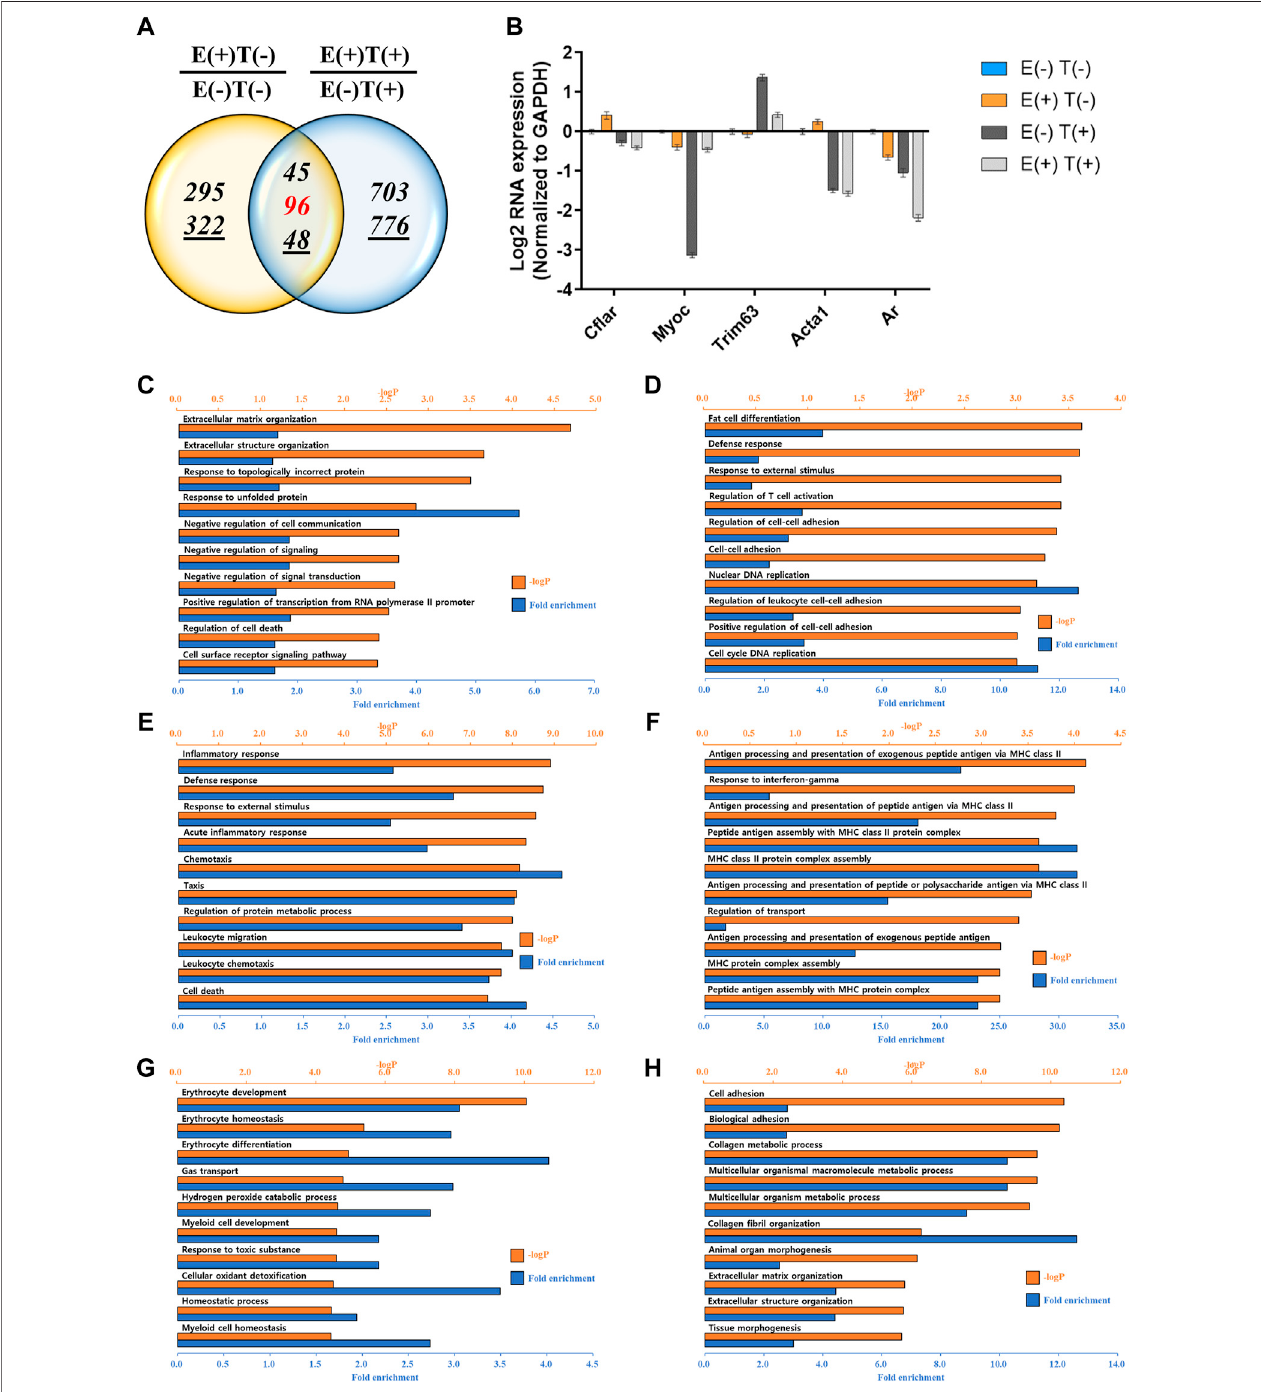
FIGURE 5 | mRNA-seq analysis of the heart. (A) Venn diagram of the number of DEGs for the effect of exercise for normal [E(+)T( − )/E( − )T( − )] and tumor-bearing [E(+)T(+)/E( − )T(+)] mice. The italicized number indicates the number of upregulated genes while the italicized and underlined number indicates the number of downregulated genes. Thosewith opposite effects between thetwogroups (contra-regulated) are shown inred. The DEGswerede fi ned asgeneswith afoldchangeof two and a normalized read count of four. (B) Bar graph of log2 fold change of selected genes in the contra-regulated group using RT-qPCR of the littermates. The foldchangewascalculatedbynormalizingthedatatothatof GAPDH andthentothelevelinthenormalcontrolgroup.Aconsistentchangecompared tothemRNA-seq analysiswasobserved. (C,D) GOanalysisoftheupregulated (C) ordownregulatedDEGs (D) comparingE(+)T( − )andE( − )T( − )mice.Exercisetriggeredtheexpressionof genes related to protein folding and matrix reorganization while decreased genes associated with DNA replication and cell-cell adhesion. (E,F) GO analysis of the upregulated (E) or downregulated DEGs (F) comparing E( − )T(+) and E( − )T( − ) mice. The presence of cancer resulted in in fl ammatory response and chemotaxis while decreased genes related to transport. (G,H) GO analysis of the upregulated (G) or downregulated DEGs (H) comparing E(+)T(+) and E( − )T(+) mice. Exercise in the cancer-bearing mice upregulated genes involved in detoxi fi cation and blood cell differentiation and downregulated genes involved in tissue morphogenesis and fi bril organization. For all GO analyses, the top 300 DEGs were used, and the top ten pathways ranked by – logP and fold enrichment are shown.